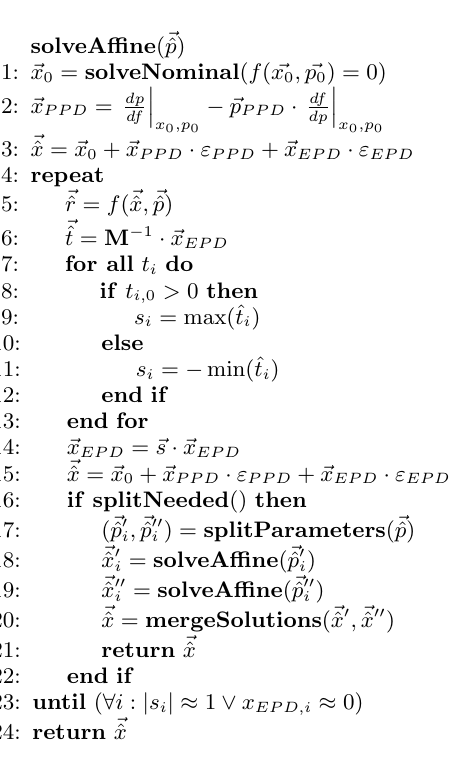
computed up to now does not preserve inclusion. This is why additional uncorrelated deviation symbols called EPD sym- bols (enhanced partial deviation) are added to each variable. Their size can only be determined iteratively. According to [3] the start value x EPD = 0 . 1 · rad(ˆ x ) is chosen. Its value will be improved in the repeat until loop (Lines 4 to 23). With the current estimation (cid:126) ˆ x the residuum of f ( (cid:126) ˆ x ) is cal- culated. This is used to calculate a refinement of the EPD symbols. These steps are repeated until the scaling factor s i